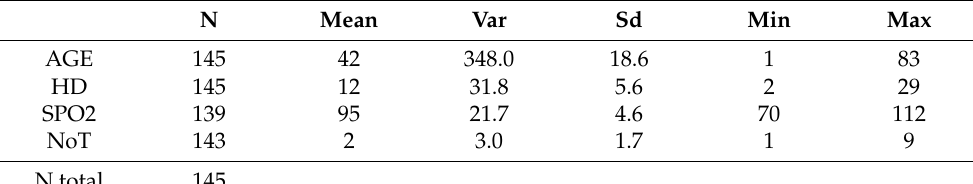
Table 2. First sample of COVID-19 patients from the first wave of infection.